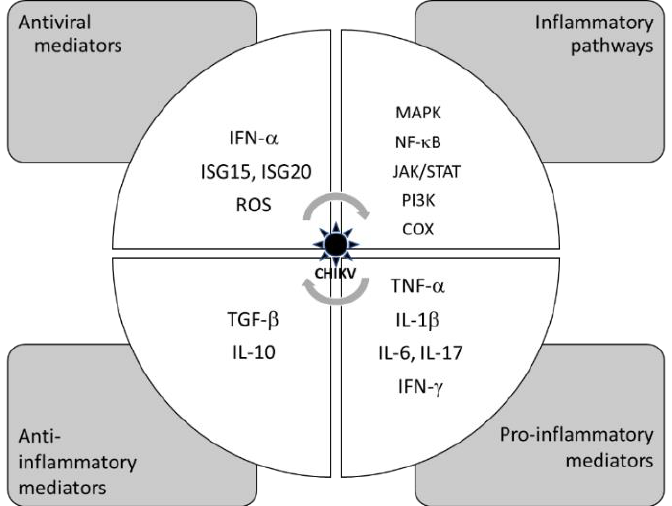
Figure 1. Simplified representation of antiviral and inflammatory components of the host immune system illustrated from cumulative experimental data for CHIKV infection and inflammation [5].